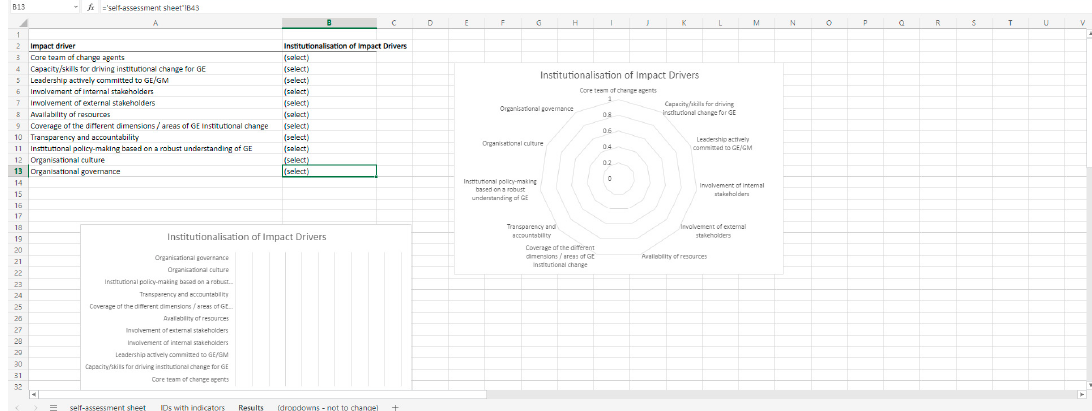
Figure 5. Third sheet of the tool, as it was tested (still with 11 Impact Drivers).